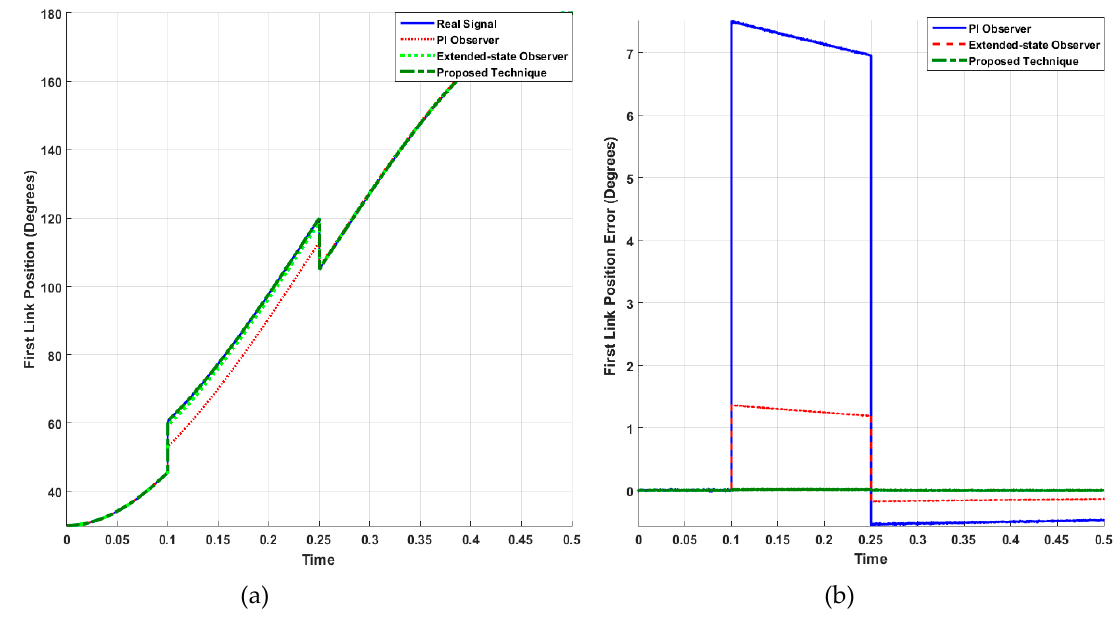
Figure 6. Proposed T–S fuzzy sliding mode extended-state ARX–Laguerre PI observer method for first link fault estimation in the faulty condition: ( a ) Real and estimation output position and ( b ) estimation error signals.